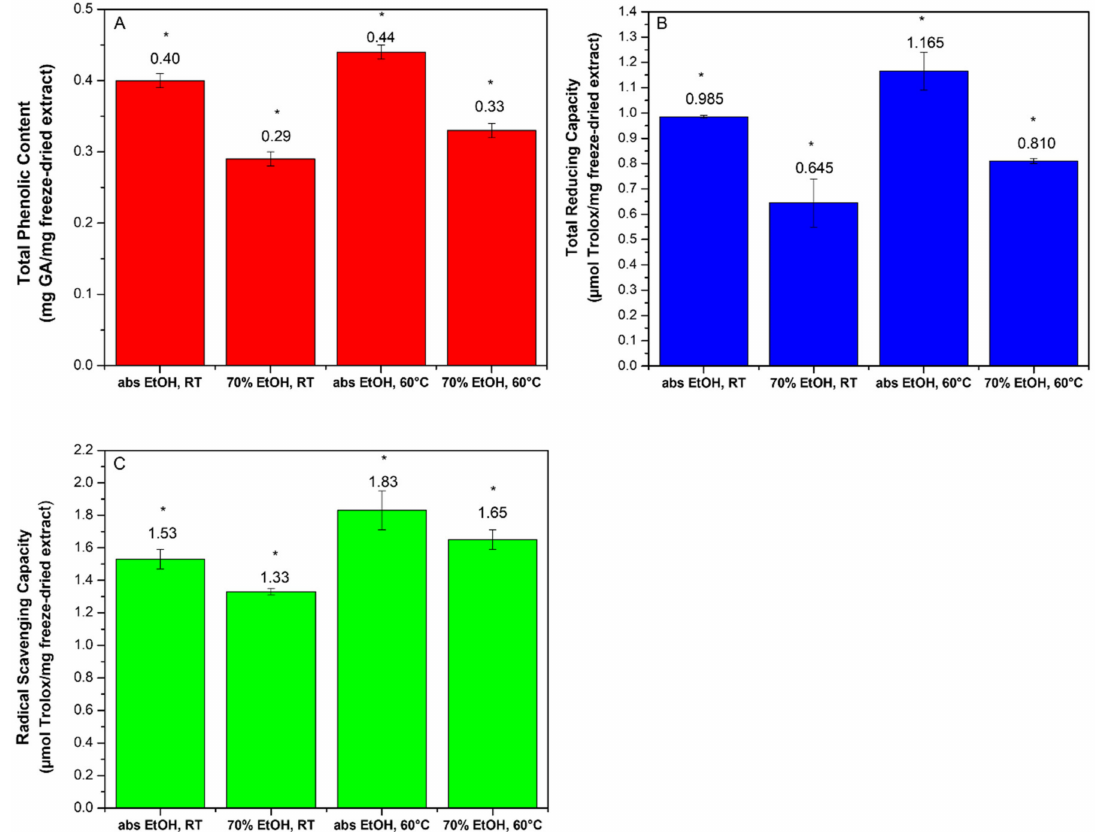
Figure 1. ( A ) Total phenol content (TPC) of the extracts obtained by the four di ff erent extraction conditions. Data are expressed as mg of GA / mg of freeze-dried extract and represent the mean of six samples, each measured in triplicate; * p ≤ 0.05 (one-way ANOVA test). ( B ) Total reducing capacity (TRC) of the extracts obtained by the four di ff erent extraction conditions. Data are expressed as mg of GA / mg of freeze-dried extract and represent the mean of six samples, each measured in triplicate. * p ≤ 0.05. ( C ) Radical scavenging capacity (RSC) of the extracts obtained by the four di ff erent extraction conditions. Data are expressed as mg of GA / mg of freeze-dried extract and represent the mean of six samples, each measured in triplicate; * p ≤ 0.05 (one-way ANOVA